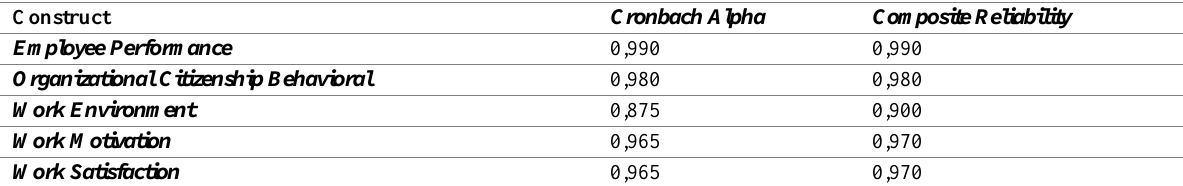
Table 3: Cronbach Alpha & Composite